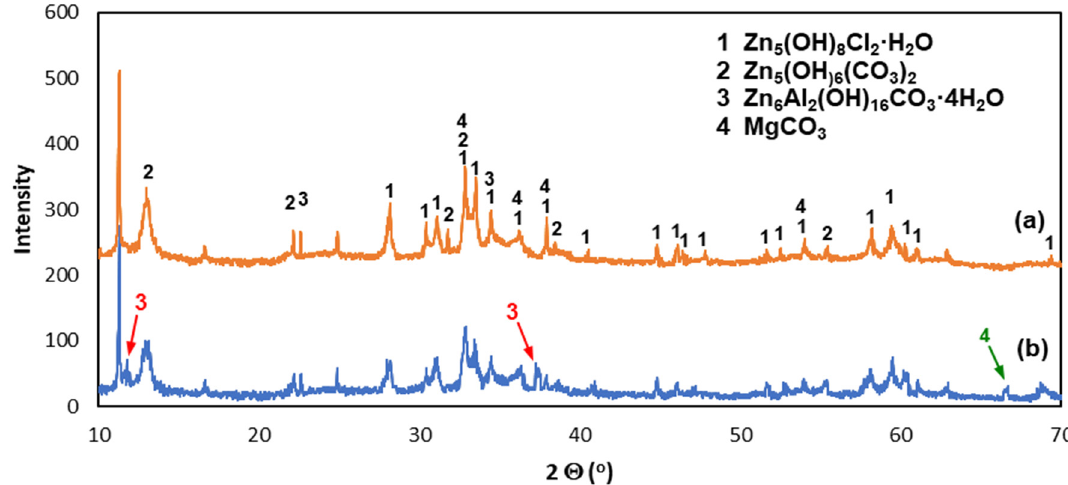
Figure 7. SEM images and corresponding EDS patterns of the corroded ZAMS coating surface after 1000 h exposure in the NSS test.